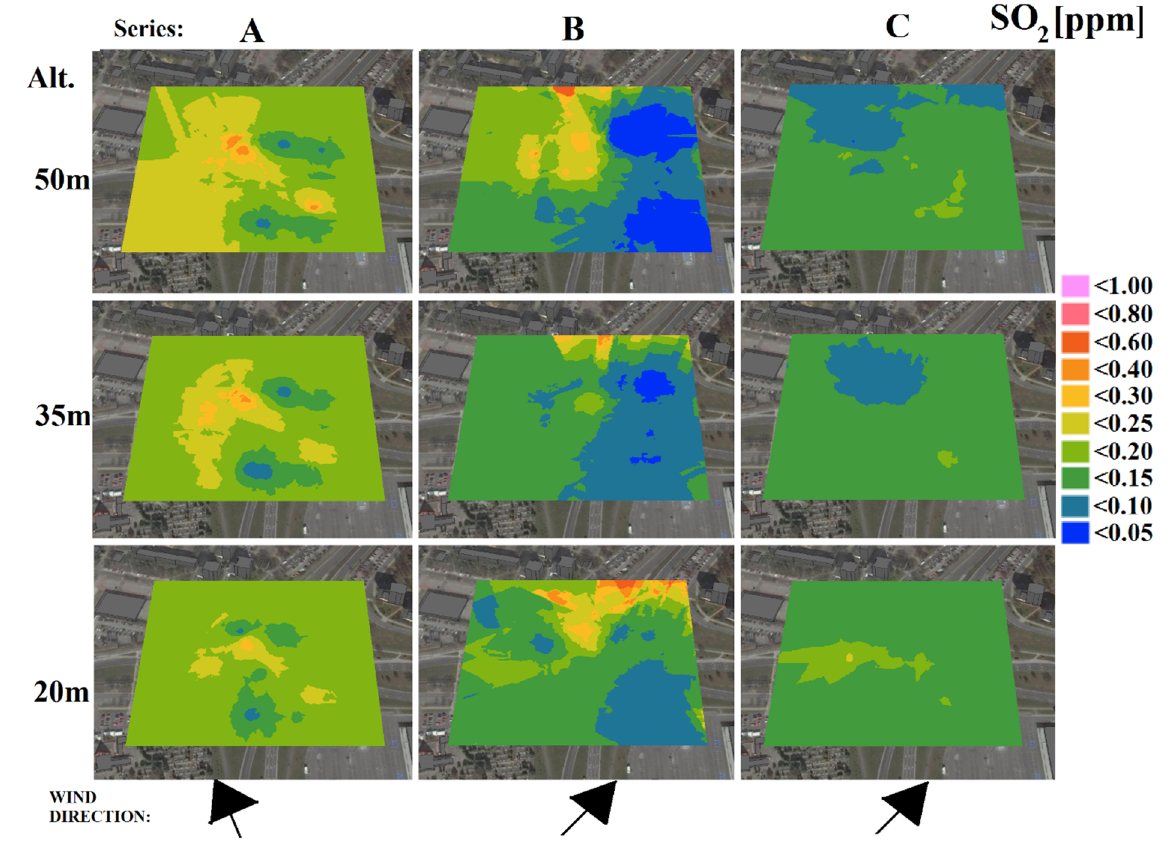
Figure 13. Spatial distribution of SO 2 pollution at the altitude of 20, 35, and 50 m for three measurement series in the area of the street intersection.